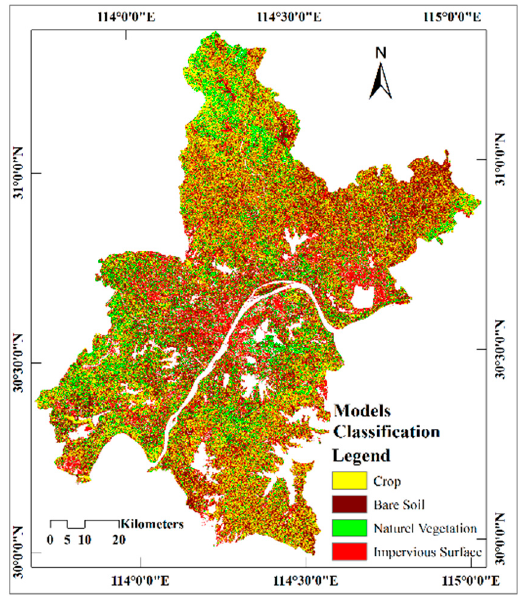
Figure 7. The classification result of models on the basis of land-cover types of endmember sources.